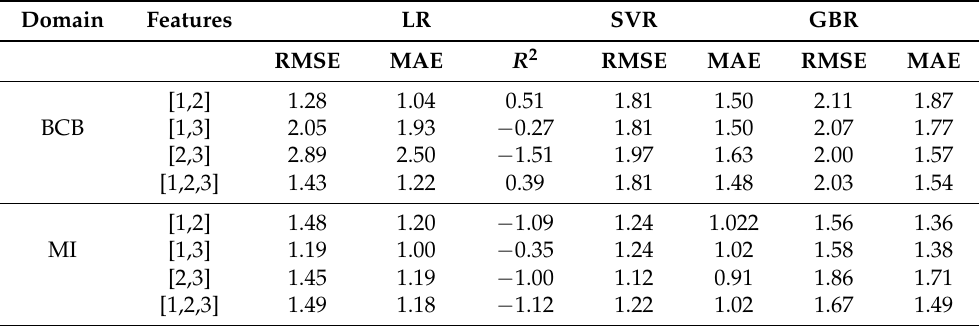
Table 6. The performances of regression models for IF predictions utilizing various input